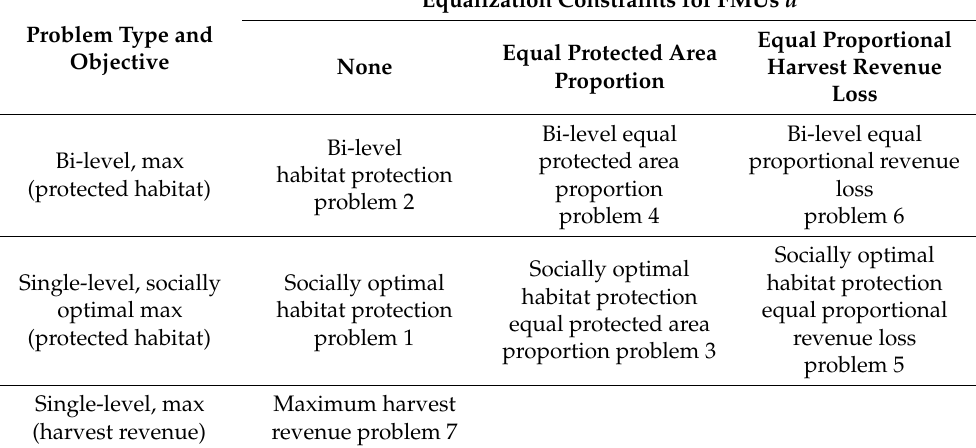
Table 2. Habitat protection and harvest problems